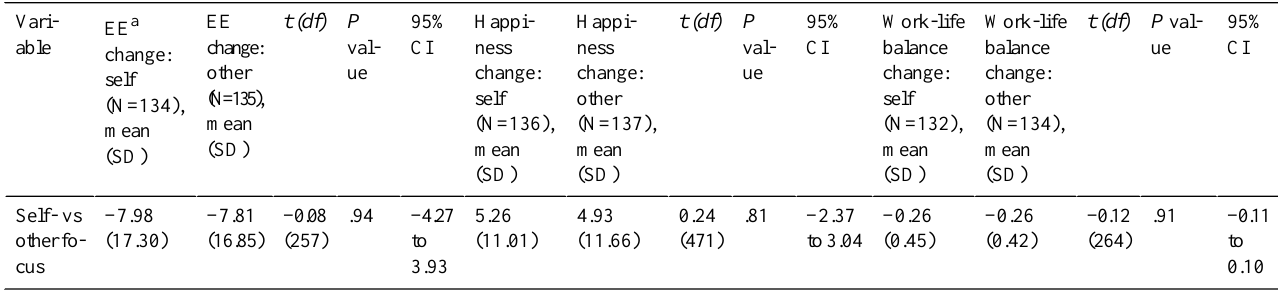
Table 2. Independent samples t tests comparing changes in well-being for participants in the self- vs other conditions.